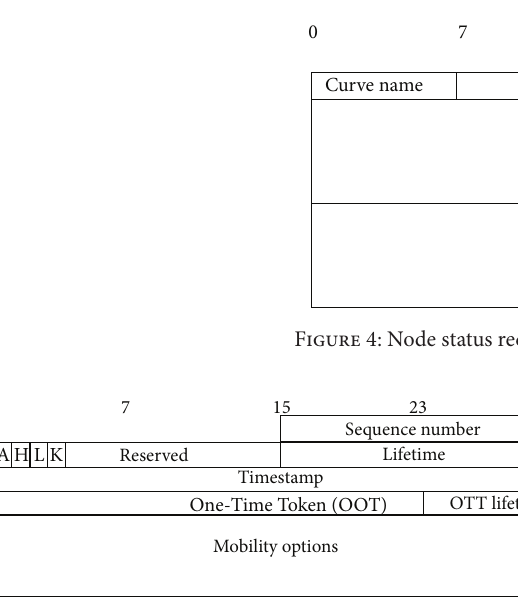
Figure 5: Modified Binding Update header